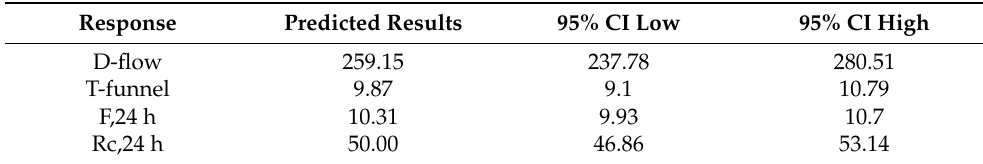
Table 15. Estimated SCHSM properties of the optimised